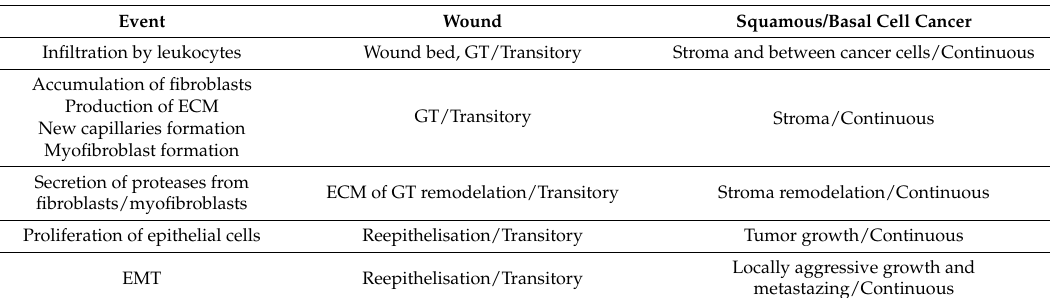
Table 1. Comparison of wound healing and squamous/basal cell carcinoma (extracellular matrix